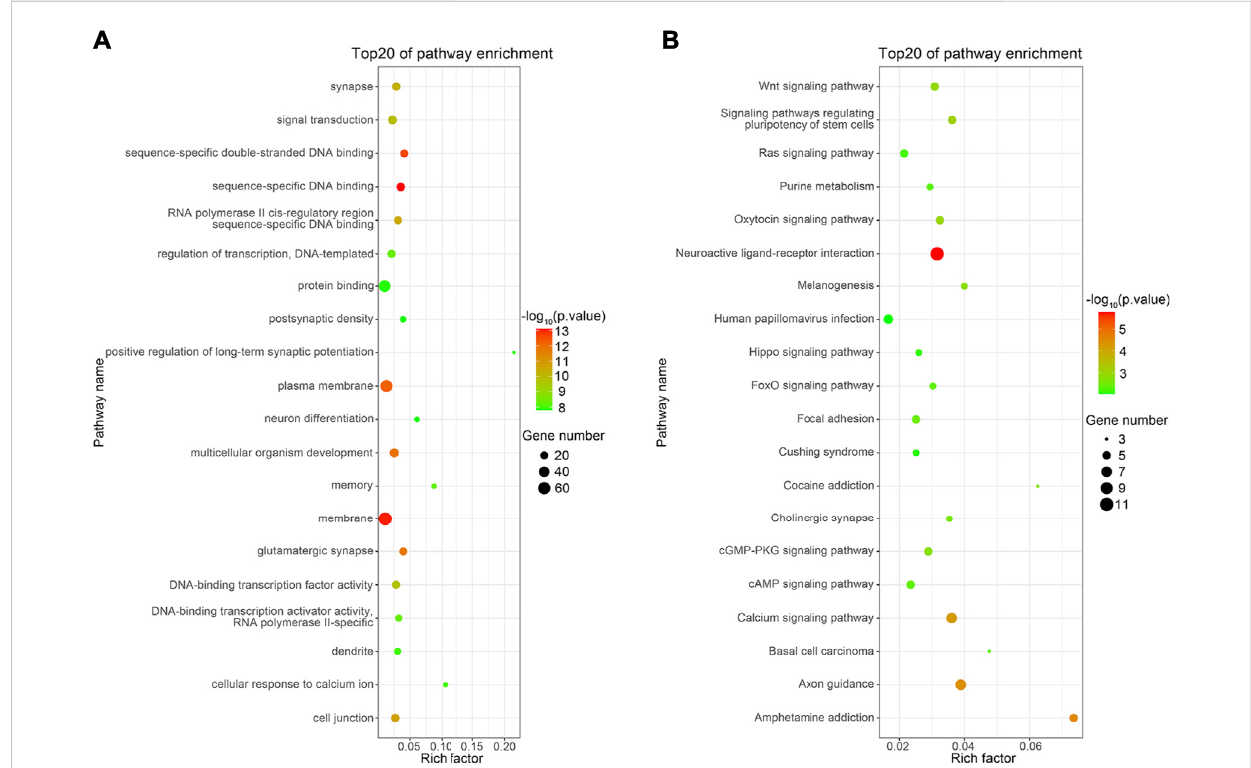
FIGURE 4 Top 20 functions enriched in GO analysis (A) and top 20 pathways enriched in KEGG analysis (B) . The Rich factor represents the enrichment degree oftheterms,andthe y -axisshowsthenamesoftheenrichedterms.Theareaofthenoderepresentsthenumberofgenes.The p -valueisrepresentedbya color scale. The statistical signi fi cance increased from green (relatively lower signi fi cance) to red (relatively higher signi fi